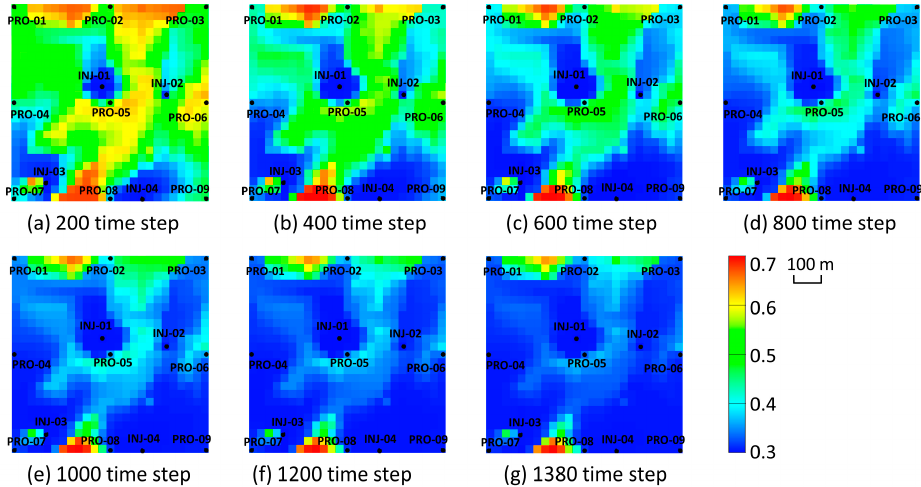
Figure 5. The oil saturation distribution at different time steps of the three-channel model.